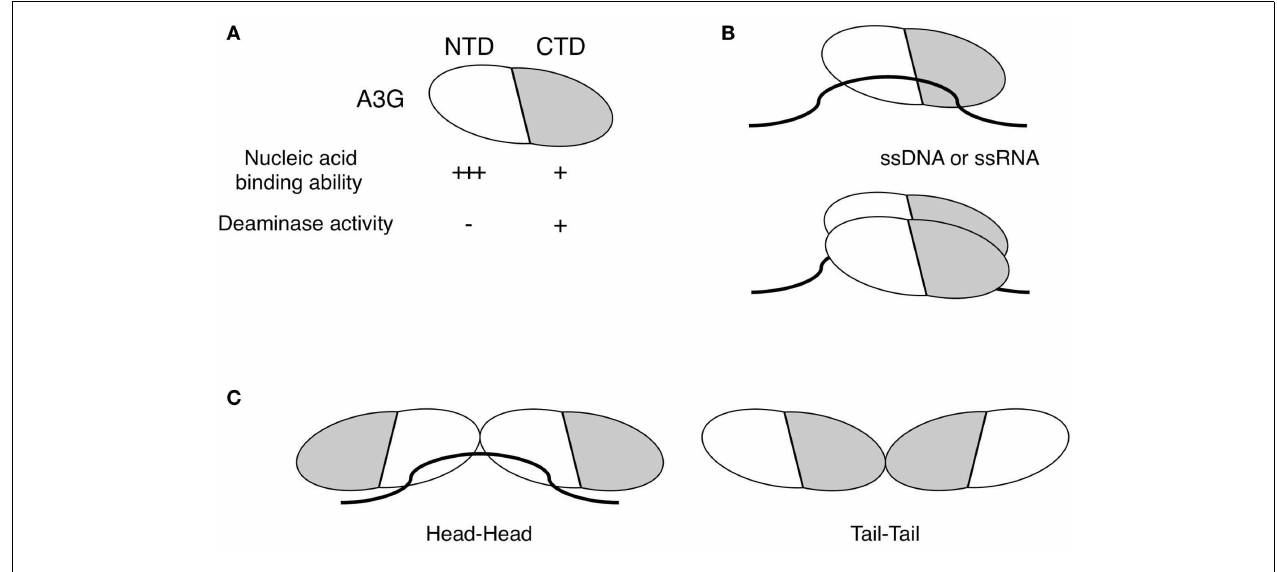
DNA (ssDNA) or RNA (ssRNA) but not to double-stranded nucleotides. A monomeric and/or dimeric A3G bind to ssDNA or ssRNA as the minimum unit. (C) The A3G protein forms homodimers or higher-order homo-oligomers through interactions between its NTDs (head–head) or CTDs